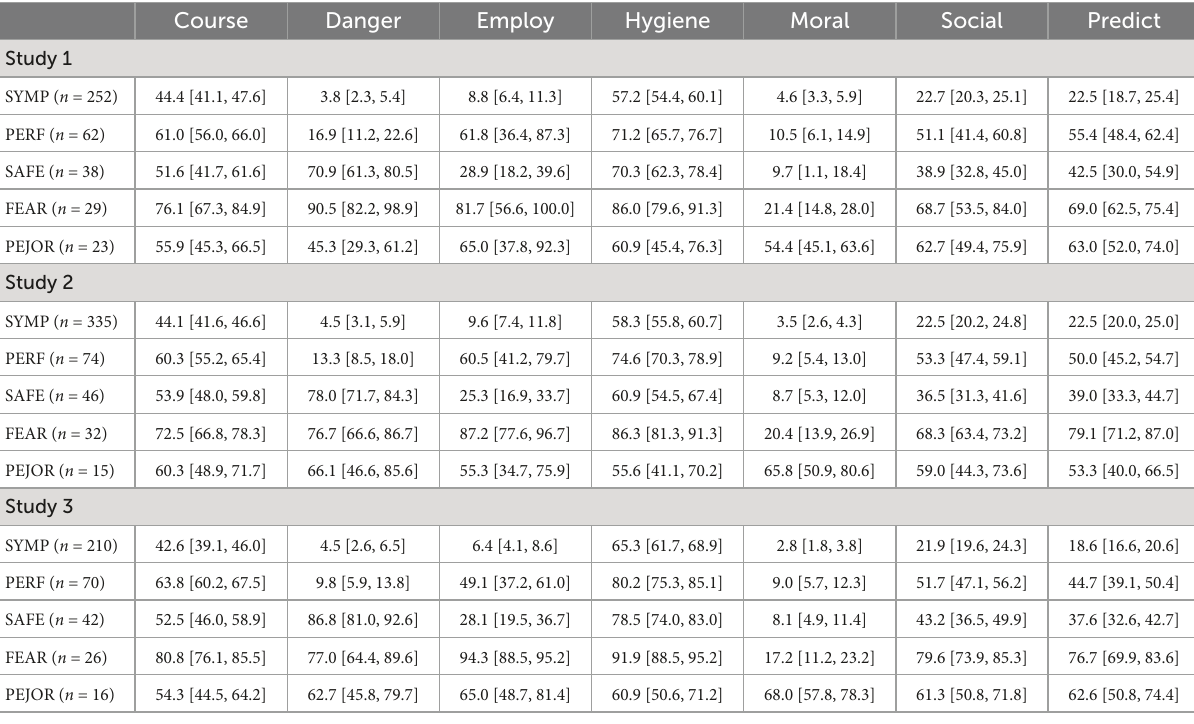
TABLE 2 Domain scores and 95% confidence intervals for Study 1, Study 2, and Study 3 a